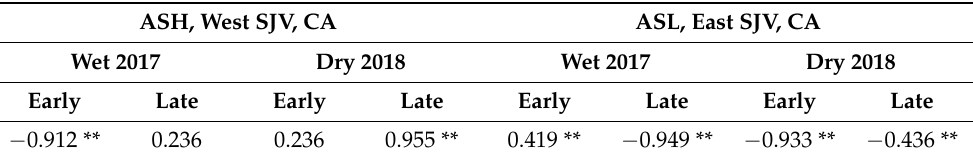
Table 6. Pearson correlation between a reduction in root water uptake and leaching fractions. ASH, West SJV,